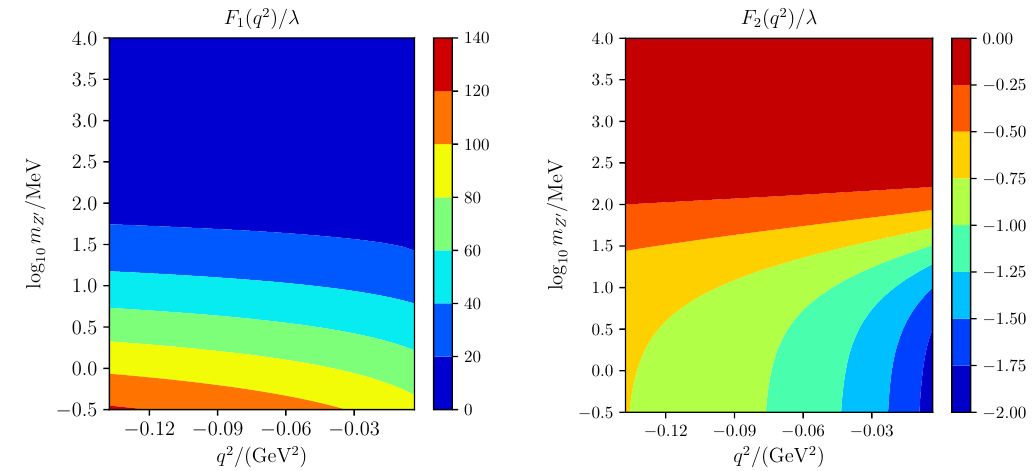
Figure 7 . Feynman diagrams of loop-level NP contributions to (cid:22) { e scattering in the L model.